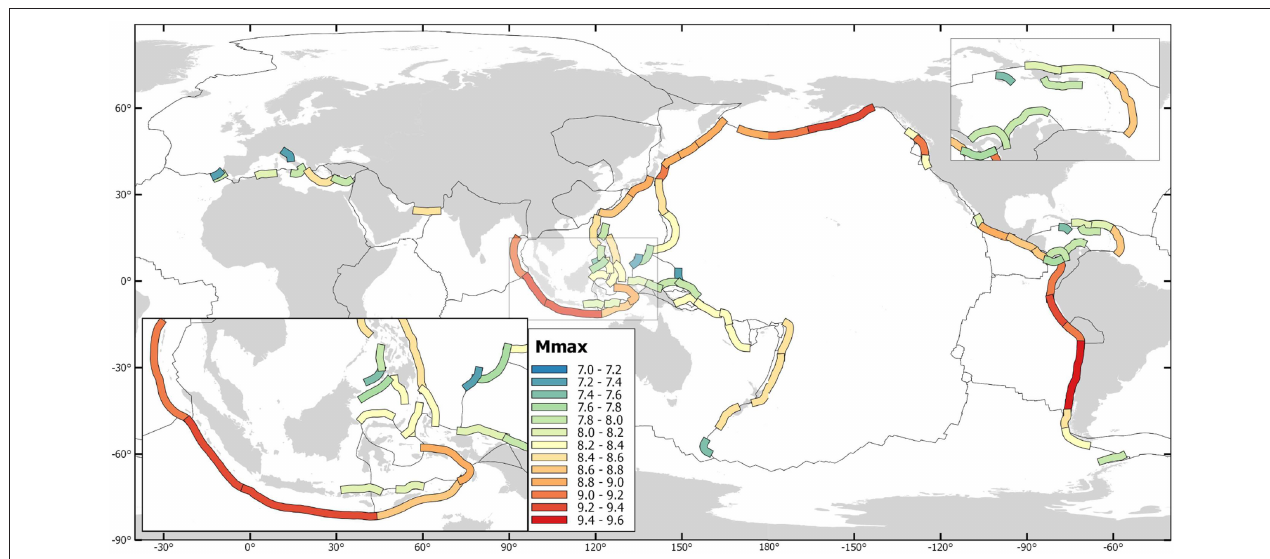
FIGURE 5 | Map of the preferred maximum magnitude estimates for all assessment subduction